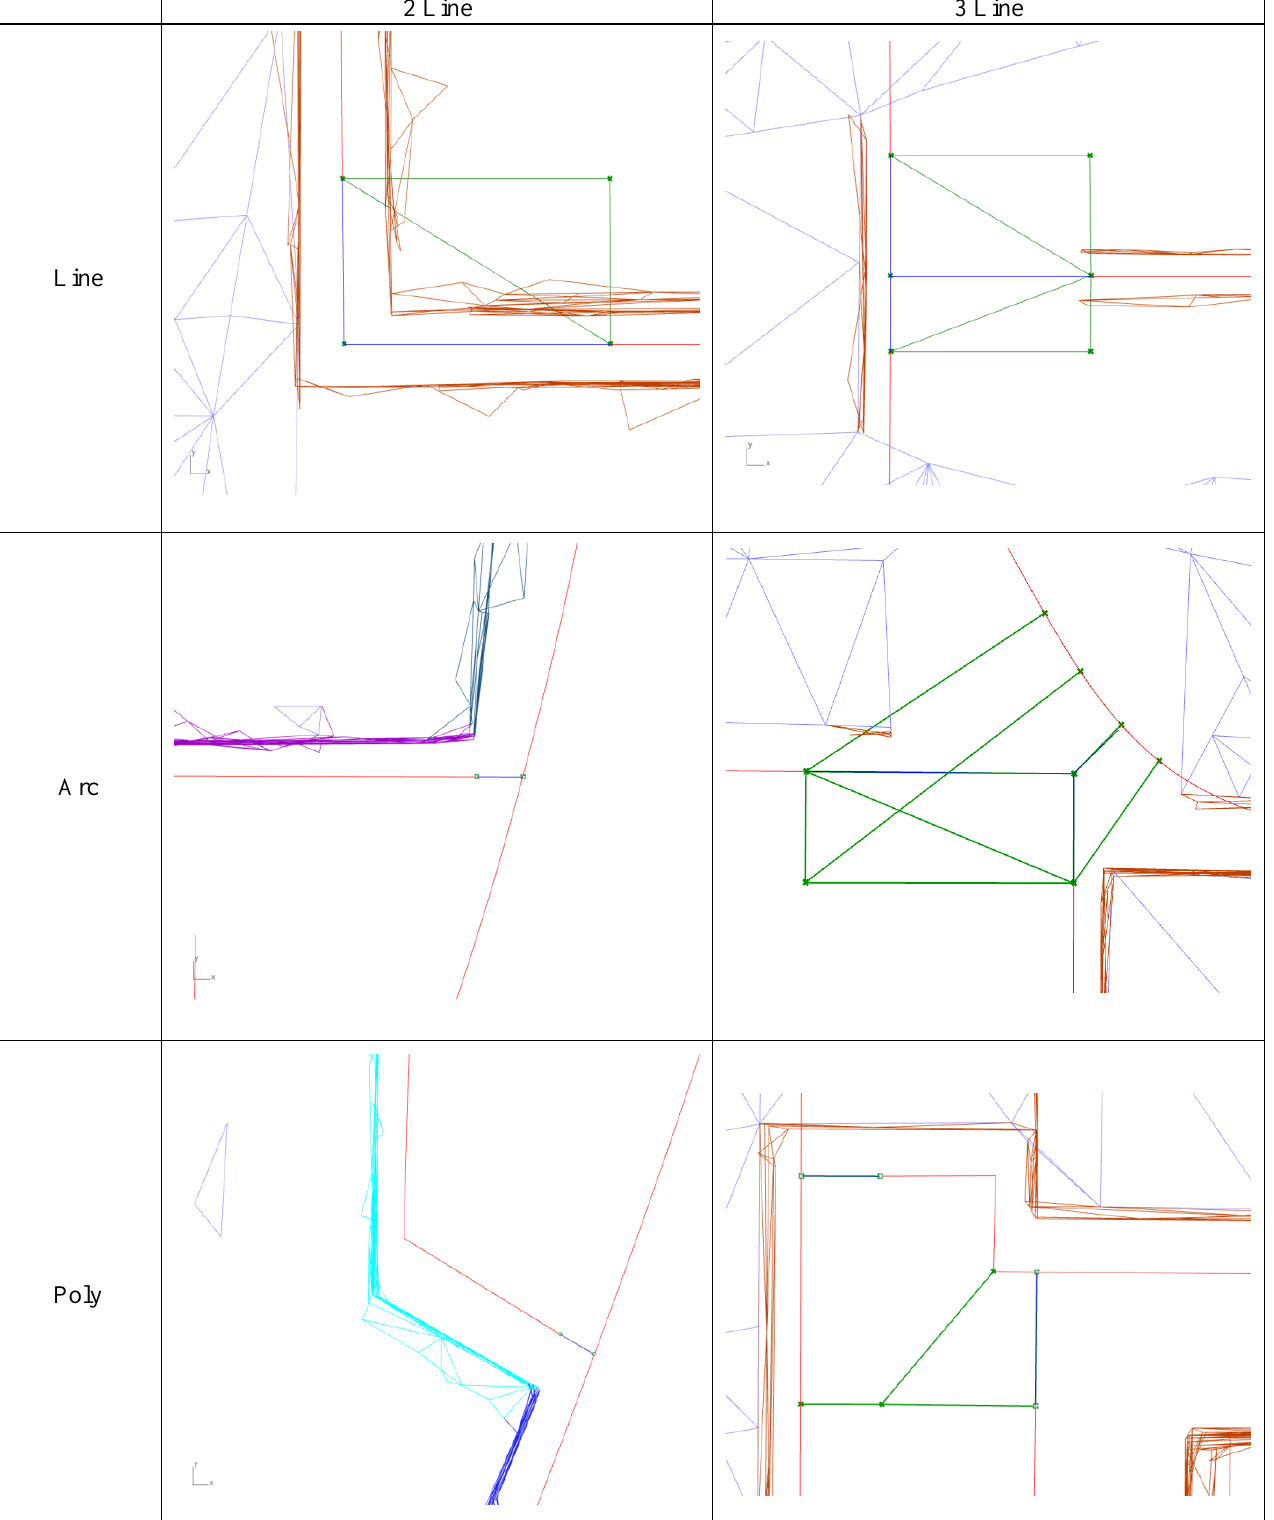
Table 1: Result of the automated topology estimation given the reconstructed centrelines. Each row represents the fitting results for the Line, Arc and Polyline for a 2 Line and a 3 Line configuration. The brown lines show the wall segments, the surrounding floor and ceiling segments are shown in purple. The potential connection C are shown as green lines and the final connections are show as blue lines. The green dots are the collection of intersection points and p and